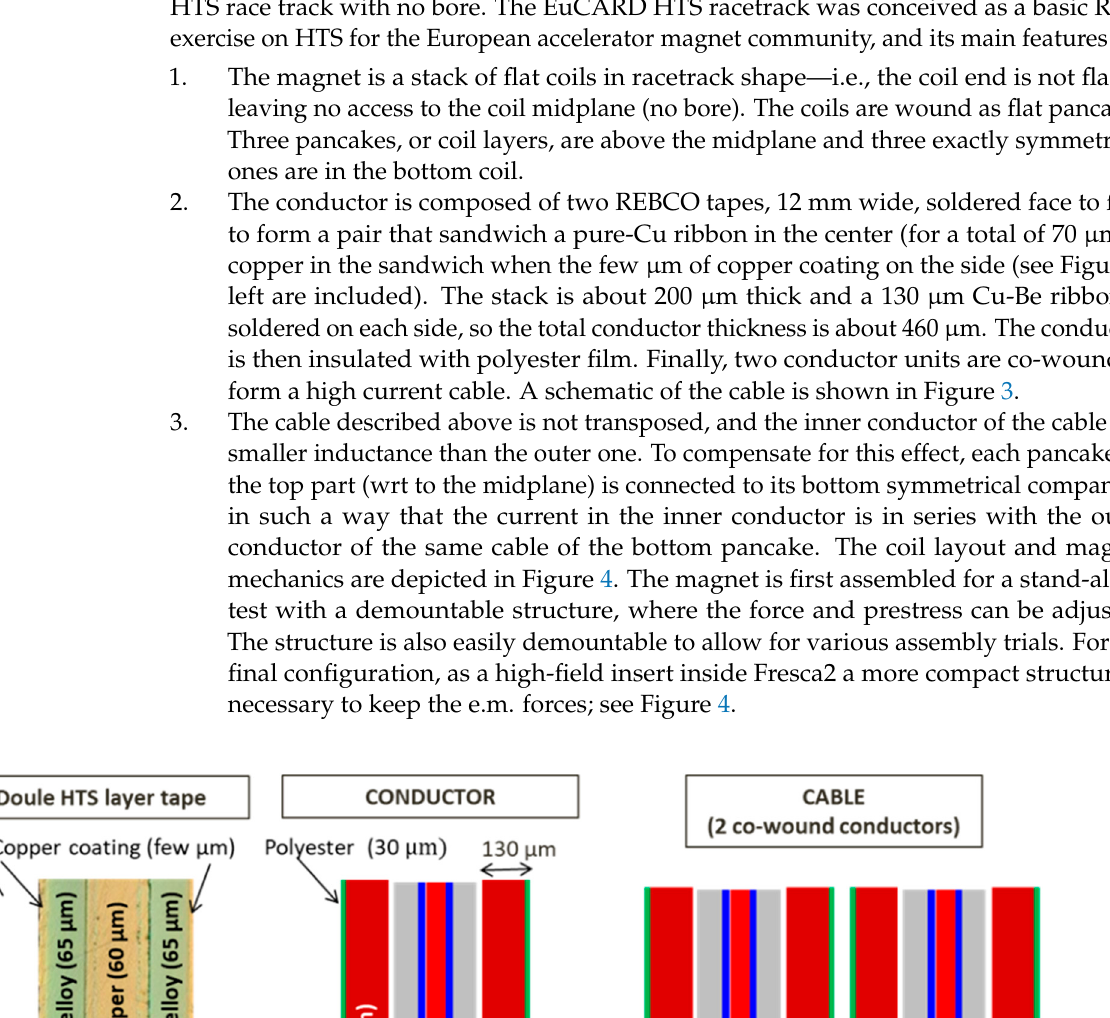
Figure 2. 3D sketch and training curve of the Fresca2 dipole. The letters a, b, and c in the quench plot refer to various assemblies and different prestress configurations. [11].